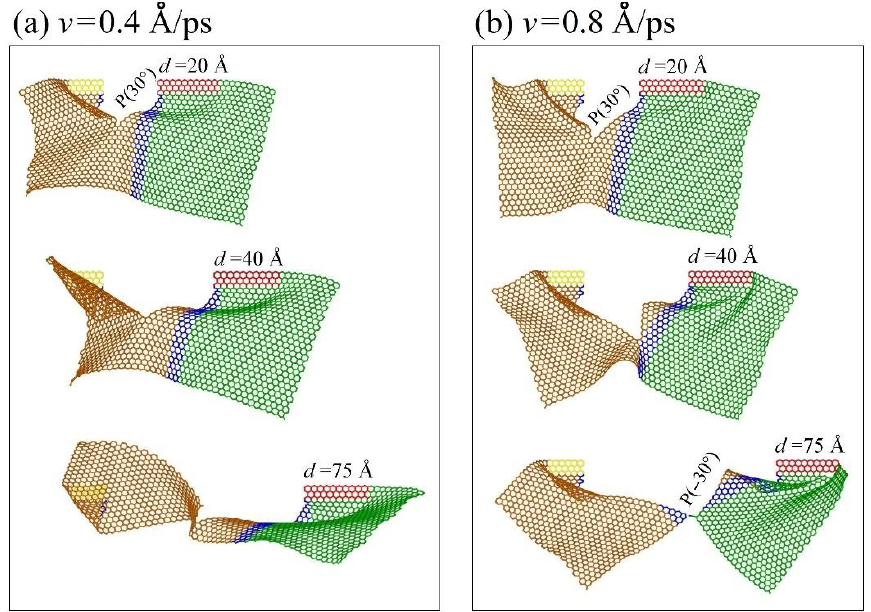
Figure 3. Snapshots of the graphene sheet (In-AC1 with AR = 0.55) in an in-plane tearing under different loading speeds at 1 K, e.g., ( a ) at v =0.4 Å/ps, ( b ) at v =0.8 Å/ps. When the graphene sheet completely breaks, VPE shows a sharp decrease, and then tends to remain constant due to the relaxation of the two pieces after they